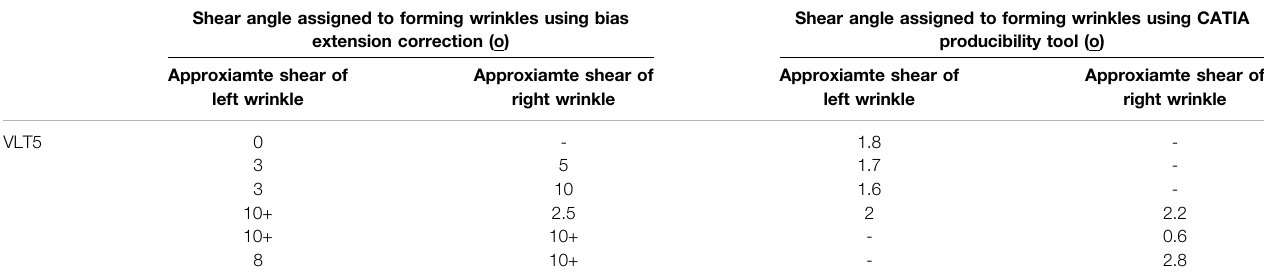
Shear angle assigned to forming wrinkles using CATIA producibility tool